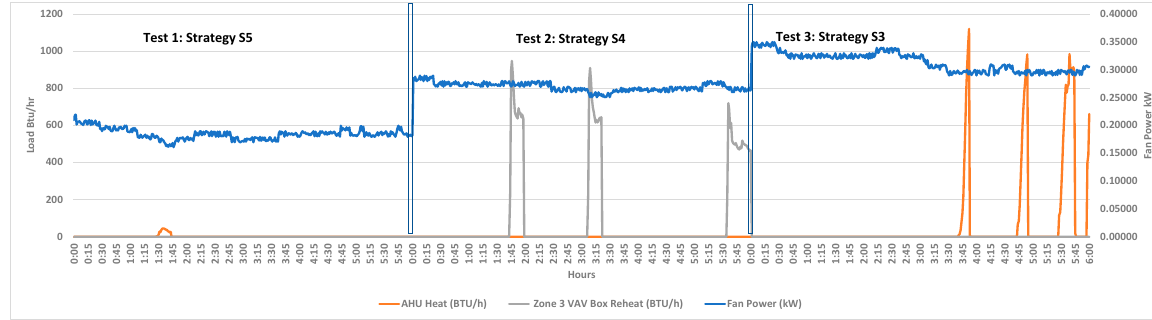
Figure 14. Heating loads and fan power when various strategies were applied.